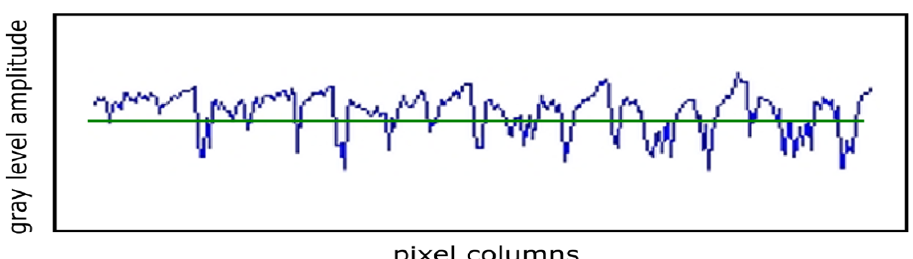
Figure 3. The time series generated by the selected area.